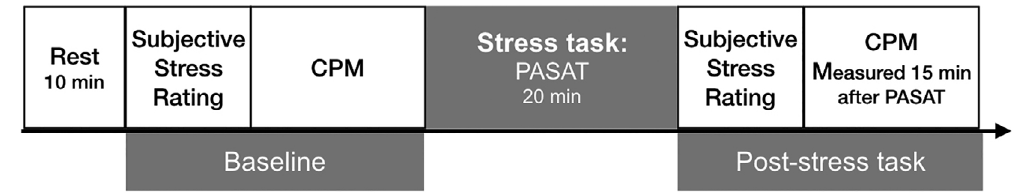
Figure 1- Experimental procedure: after resting for 10 min, subjective stress and CPM (conditioned pain modulation test) were measured. The subjective stress was rated on an analogic visual analog scale (0 = no stress and 10 = most intense stress imaginable). Sequential CPM protocol was performed by applying pressure pain threshold on masseter muscle as test stimulus and immersion of hand in hot water bath as conditioning stimulus. Two trial of PASAT was followed by post-stress task